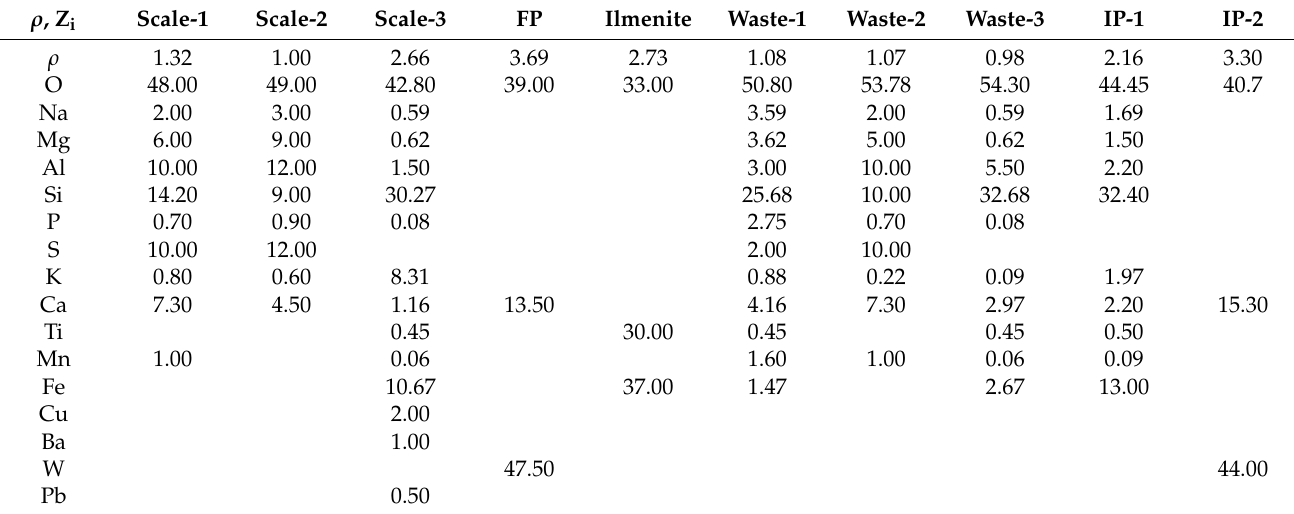
Table 2. Chemical compositions (each chemical element, Z i , given in %) and apparent densities ( ρ , in g·cm − 3 ) of the mining samples analyzed in this work.